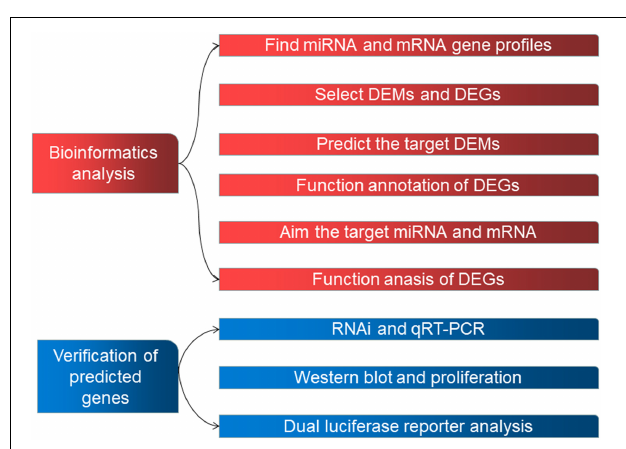
FIGURE 1 | The workflow used in this